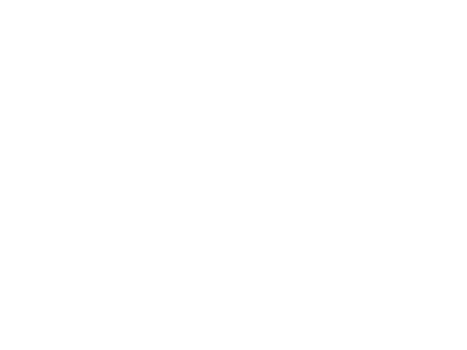
Table 4. Loadings matrix for factor analysis.